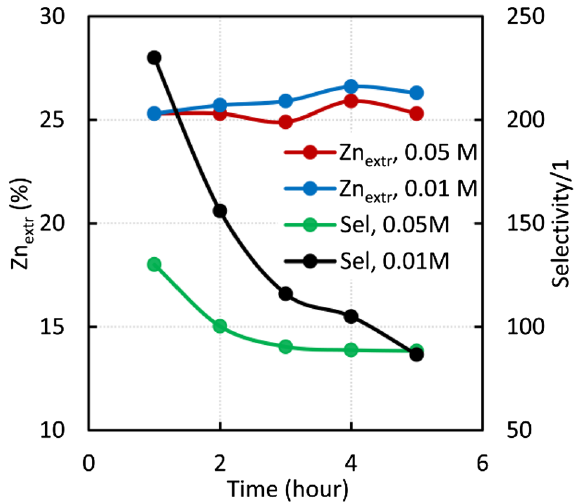
Figure 3. Time dependence of metal extraction and selectivity of the sludge (0.1 g) in 0.5 mol of acetic acids.